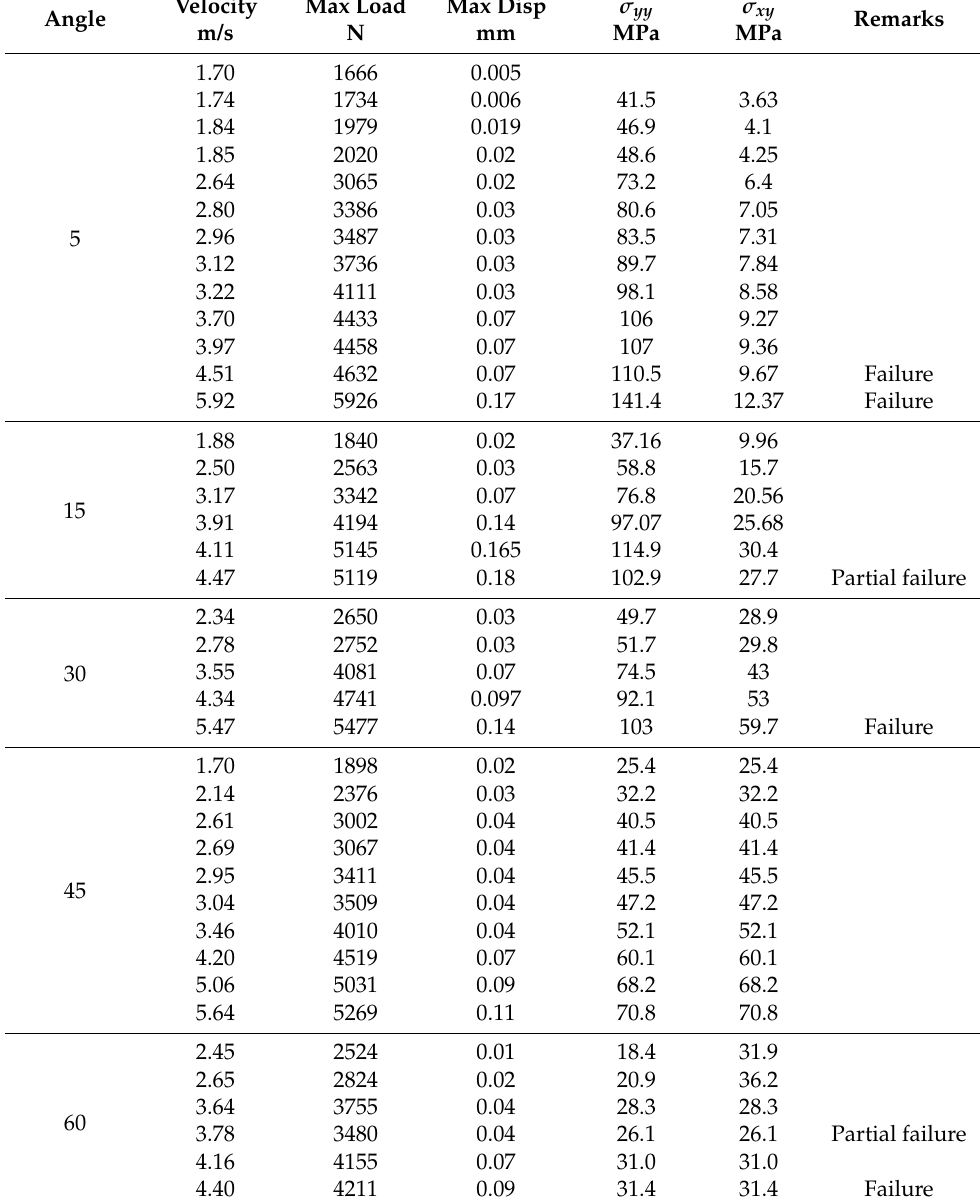
Table 4. Results of SCS under dynamic